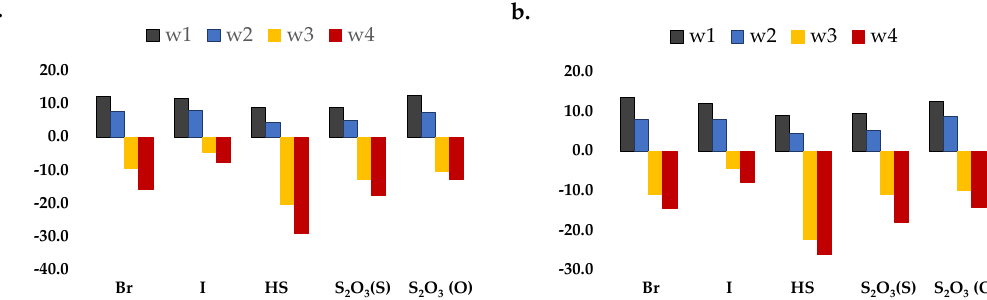
Figure 4. Reaction force works for the nucleophilic substitution reaction of alachlor ( a ) and propachlor ( b ).